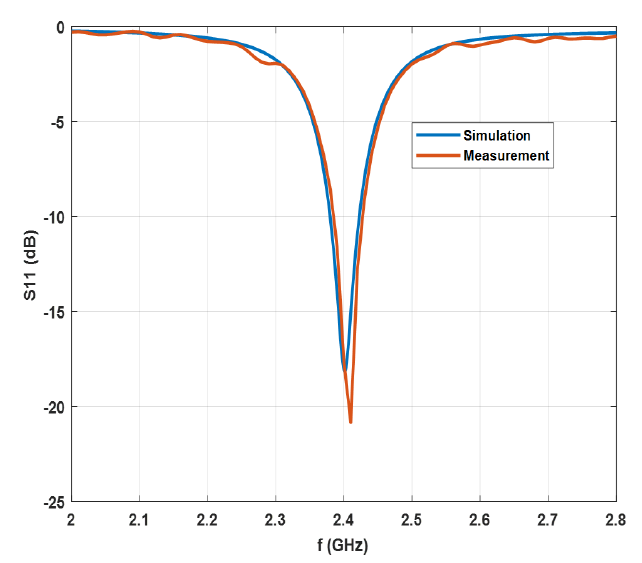
Figure 21. Simulated and measured reflection coefficient ( | S 11 | ) of the